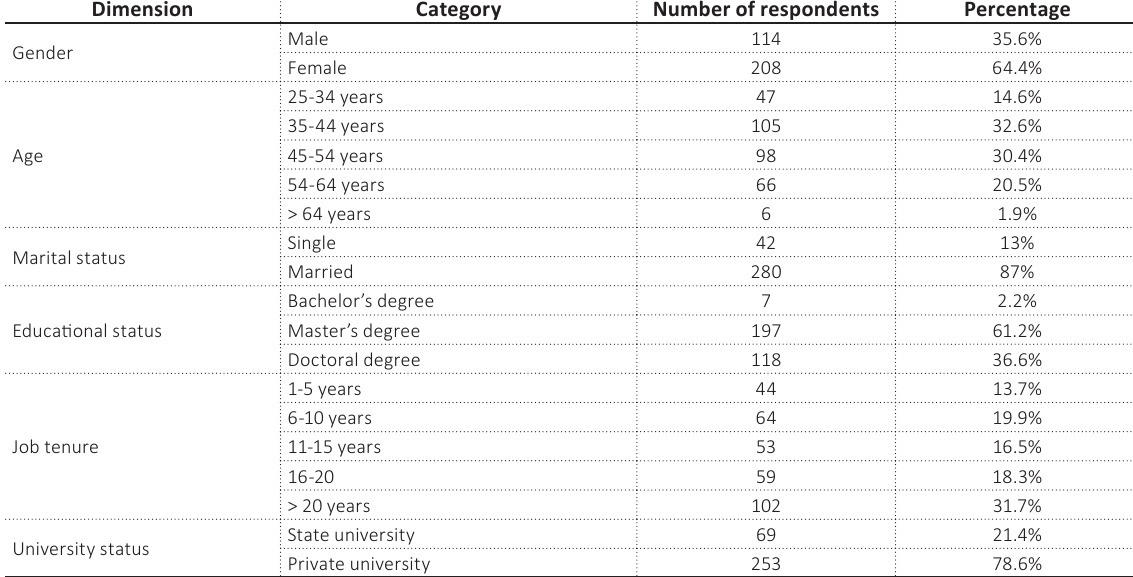
Table 2. Validity and reliability test